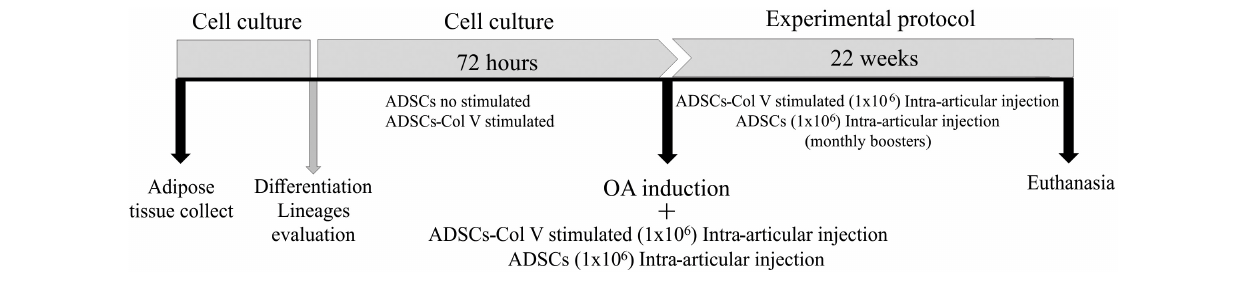
FIGURE 1 | Schematic protocol of cell culture, OA induction, and treatment with Col V-stimulated ADSCs and ADSCs (Col V-unstimulated ADSCs). ADSCs, adipose stem cells; Col V, collagen V.